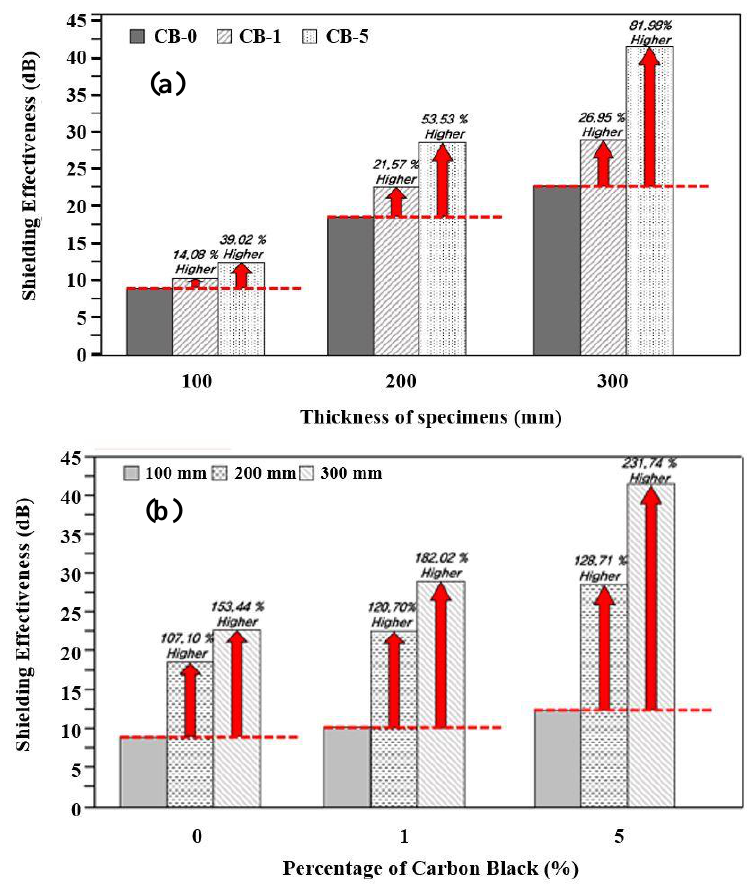
Figure 5. E ff ect of ( a ) carbon content and ( b ) concrete thickness on EMP performance of specimens before application of ATMSM coating.